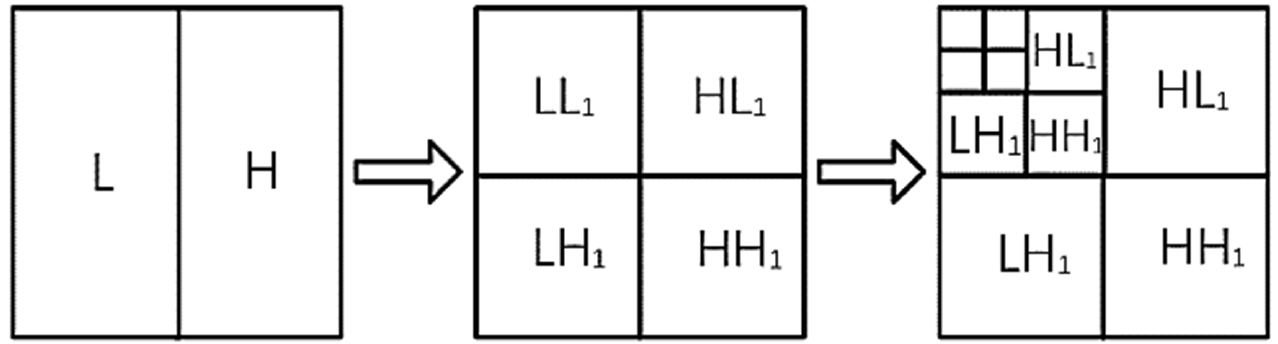
Figure 5. Schematic diagram of wavelet decomposition.